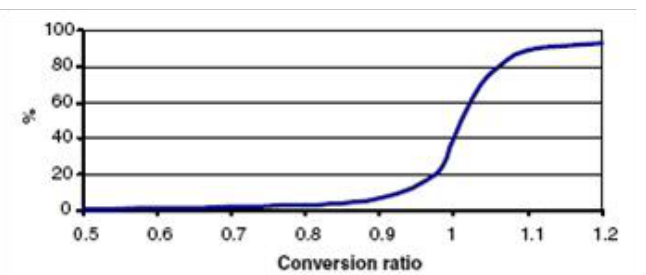
Figure 26. Percentage of natural resources utilisation as a function of the conversion ratio © 2007 Elsevier, reproduced with permission from